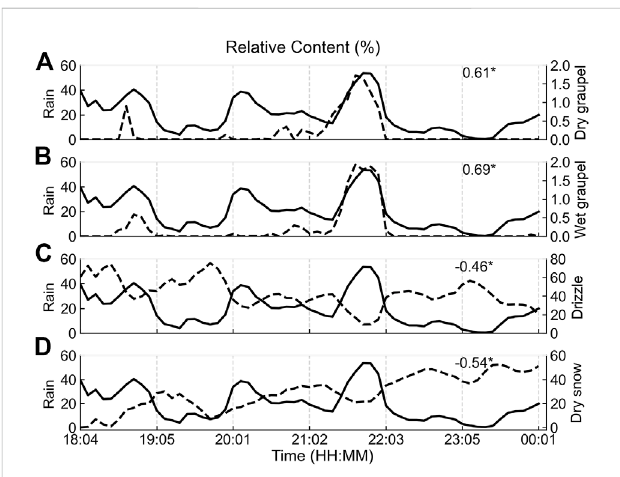
FIGURE 6 Time series of the relative content of rain, dry graupel, wet graupel, drizzle, and dry snow in Region 1. The black solid line represents rain particles, the black dashed line in (A – D) represents dry graupel, wet graupel, drizzle, and dry snow, respectively. The number shows their correlation coef fi cient, and * indicates the value passes 95% signi fi cance